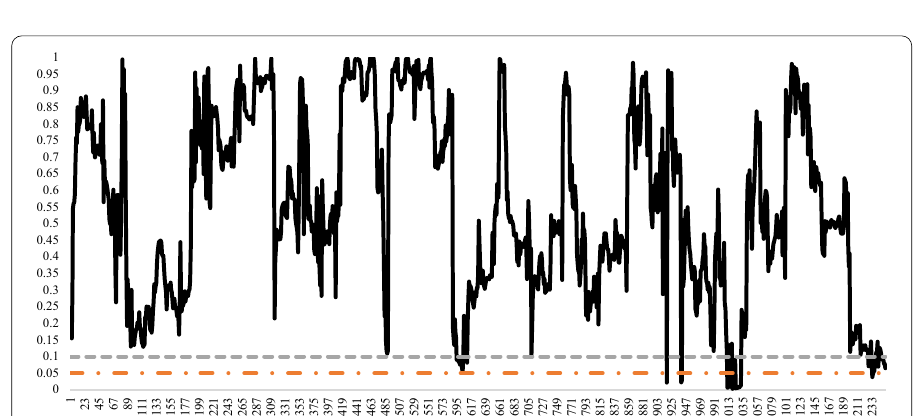
00.050.10.150.20.25 Fig. 9 The evolving p values of the AQ test statistic checked for Ethereum (ETH) in 100-day window